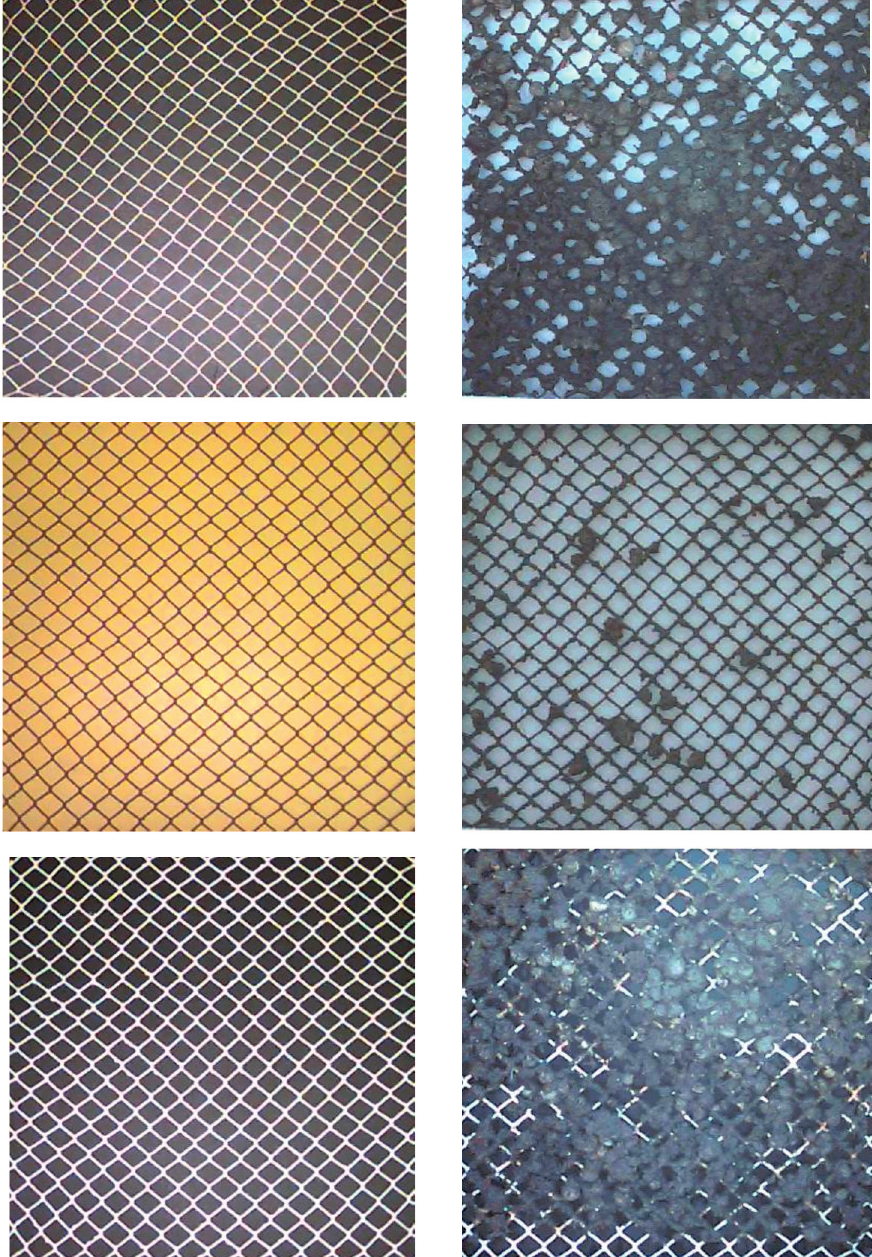
Figure 1. The condition of representative nets at the start of the experiment and after 148 days immersion. Top uncoated; Middle copper; Bottom